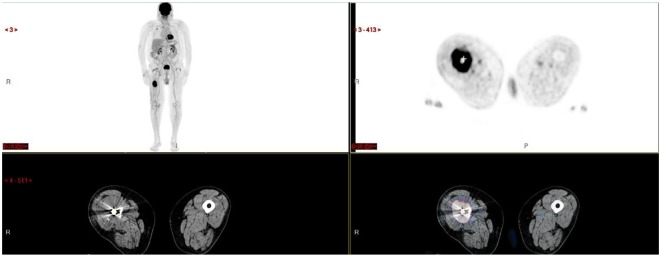
Voluminous hypermetabolic lytic lesion of the right femoral shaft contiguously invading adjacent soft tissues.